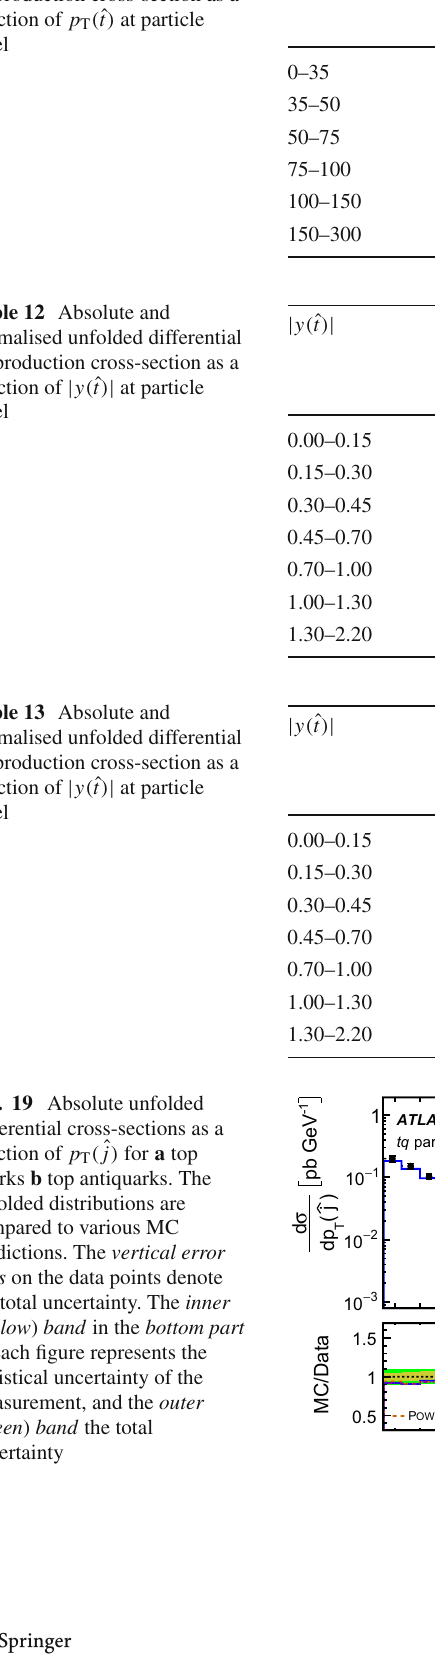
normalised unfolded differential ¯ tq production cross-section as a function of p T ( ˆ t ) at particle